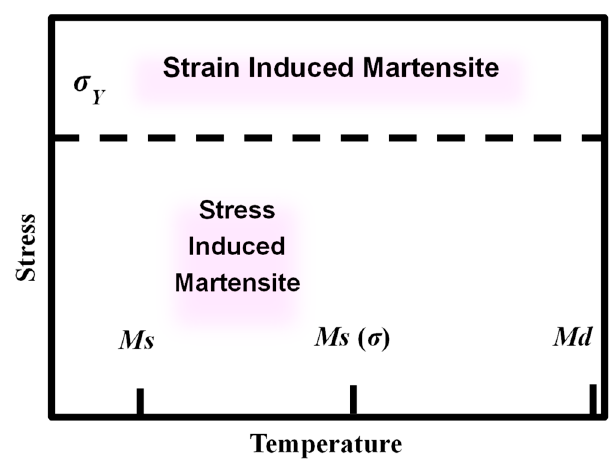
Figure 16. The simplified schematic representation of the different phase transformations that occur under either an applied constant or increasing stress as a function of the deformation temperature. The stress where the phase transformation begins is at the yield strength, σ Y .